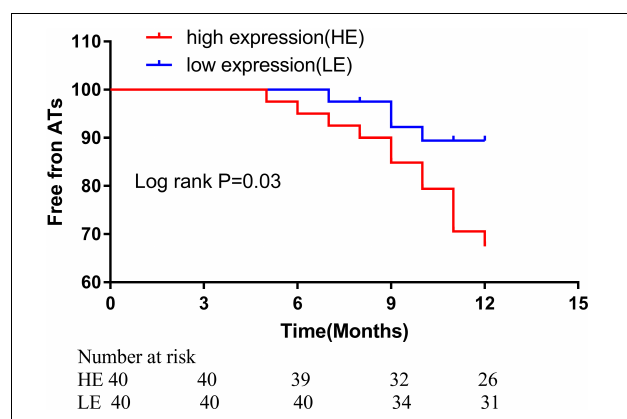
FIGURE 7 | Kaplan–Meier freedom rate from ATa during different points after catheter ablation (high expression level: 70.0% vs. low expression level 90.0%, ratio: 3.05, 95%CI, 1.13–8.25, p = 0.04. ATa: atrial tachyarrhythmia.